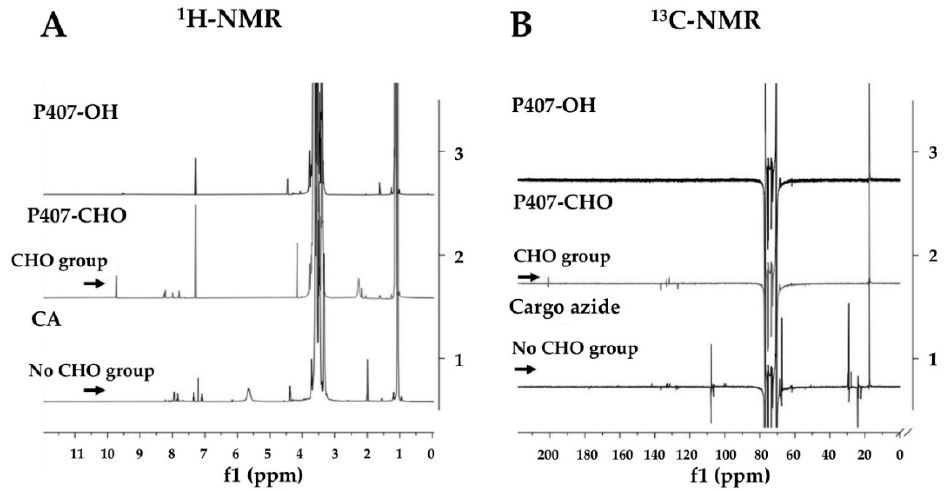
Figure 7. Characterization of cargo azide (CA). ( A ) 1 H-NMR and ( B ) 13 C-NMR spectrum of P407-OH, P407-CHO, and CA.